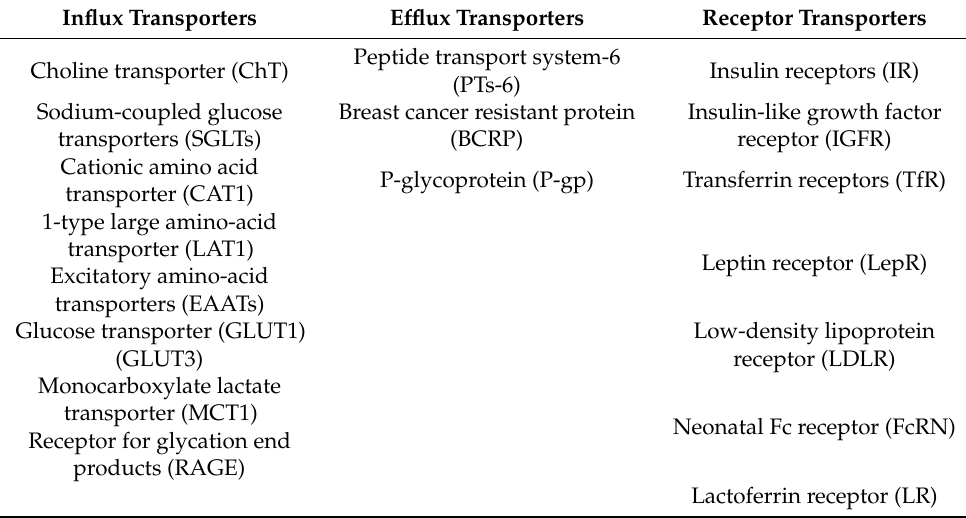
Table 3. Various transporters that penetrate the